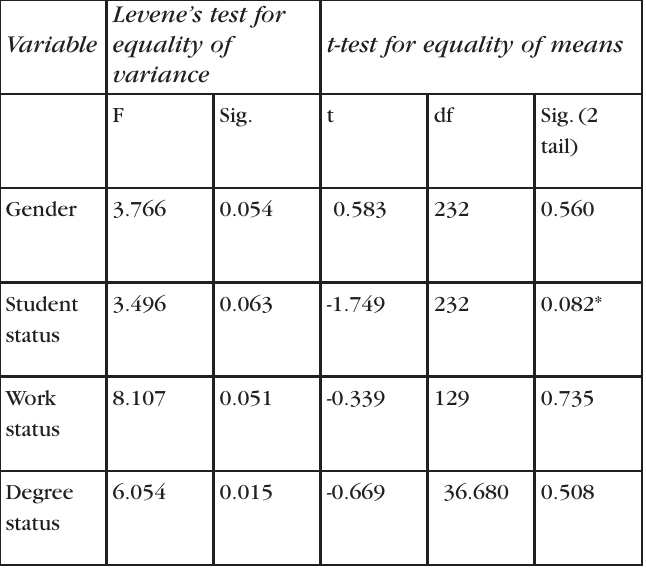
Table 4. T-test for Gender, Student Status, Occupation, and Degrees Levene’s test for Variable equality of